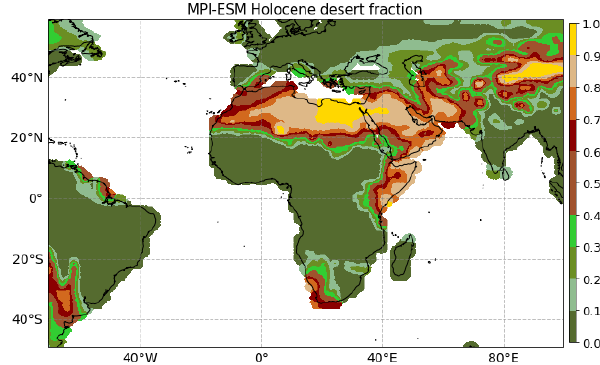
Figure A1. MPI-ESM desert fraction from the transient Holocene simulations. 0: no desert area within a grid box, 1: the whole grid box is